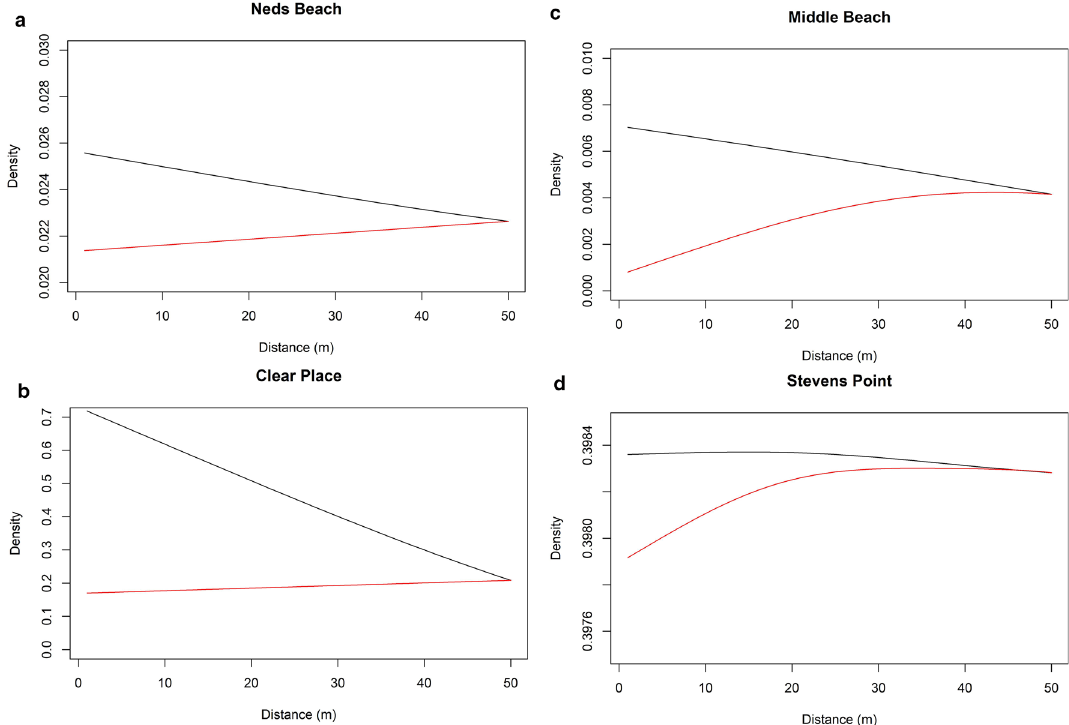
Figure 8. Predictions of burrow density at progressive distances (up to 50 m) while holding all other variables constant. Plots for each of the 4 main colonies; black = roads, red =